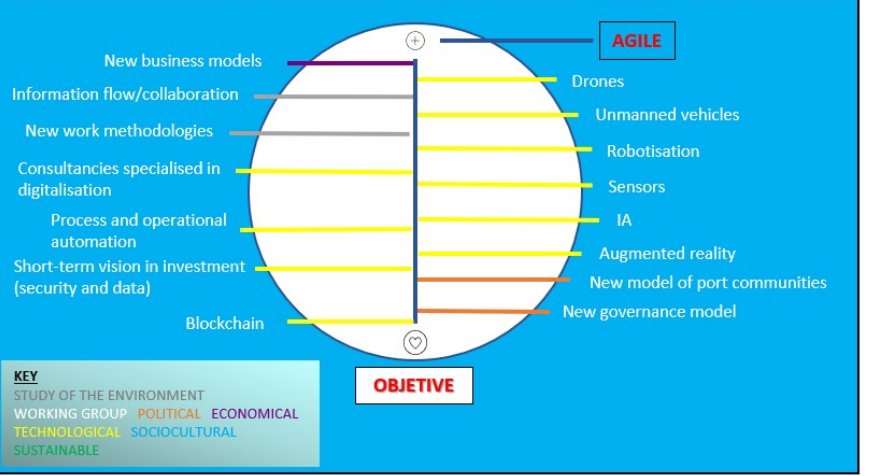
Figure 22. Elements of agile ports. Source: own elaboration. It can be seen that modern ports that